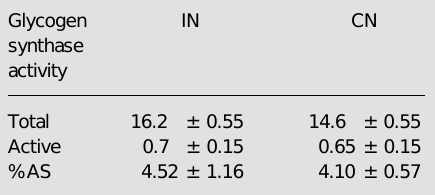
Table 3 - Activities of the total and active forms of glycogen synthase and proportion of the active form (%AS) in rats which received saline (CN group, glycemia: 144.7 ± 2.4 mg/dl) or insulin (IN group, glycemia: 42.4 ± 3.6 mg/dl) 1 h before hepatic perfusion. Glycogen synthase activity was assayed in liver samples collected 10 min before the infusion of phenylephrine or isoproterenol (time 0). Data are reported as the mean ± SEM for 6 rats of glyco- gen synthase activity (nmol mg -1 min -1 ).